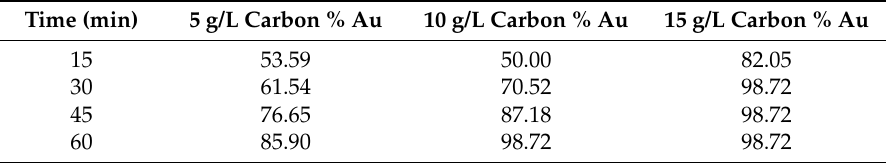
Table 4. Kinetics of Au adsorption at different concentrations of carbon in solution.